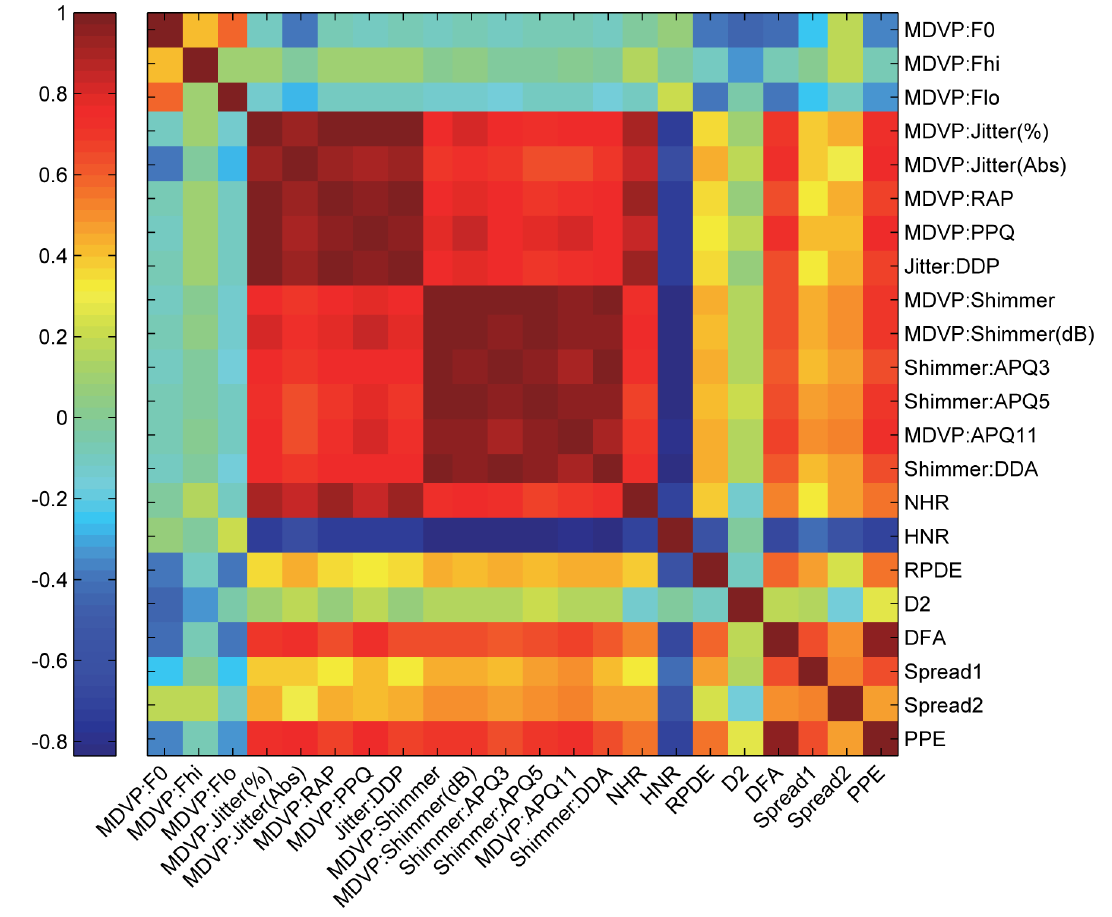
Figure 2. Graph visualization of correlation matrix for the vocal measurements, with the color map ranging from blue (for negative correlation coefficient) to red (for positive correlation coefficient).